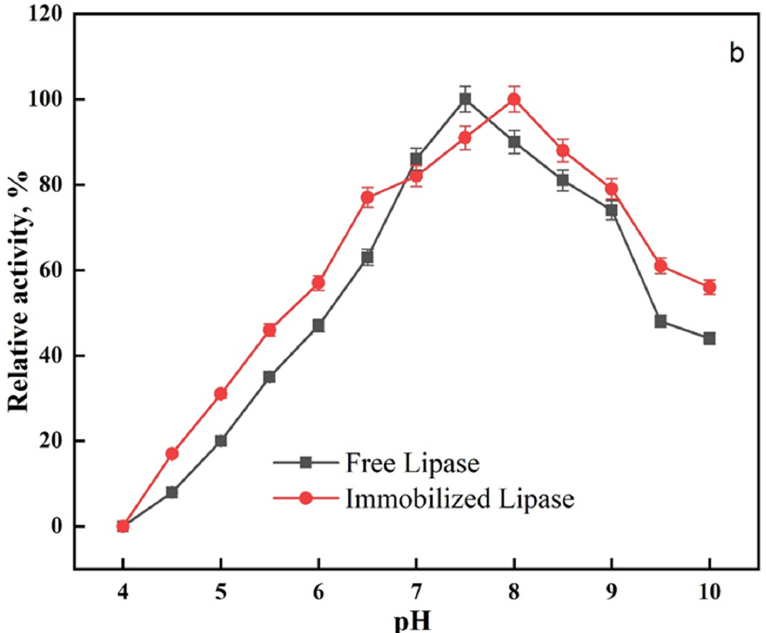
Figure 5. Effect of ( a ) temperature and ( b ) pH on the activity of free and immobilized